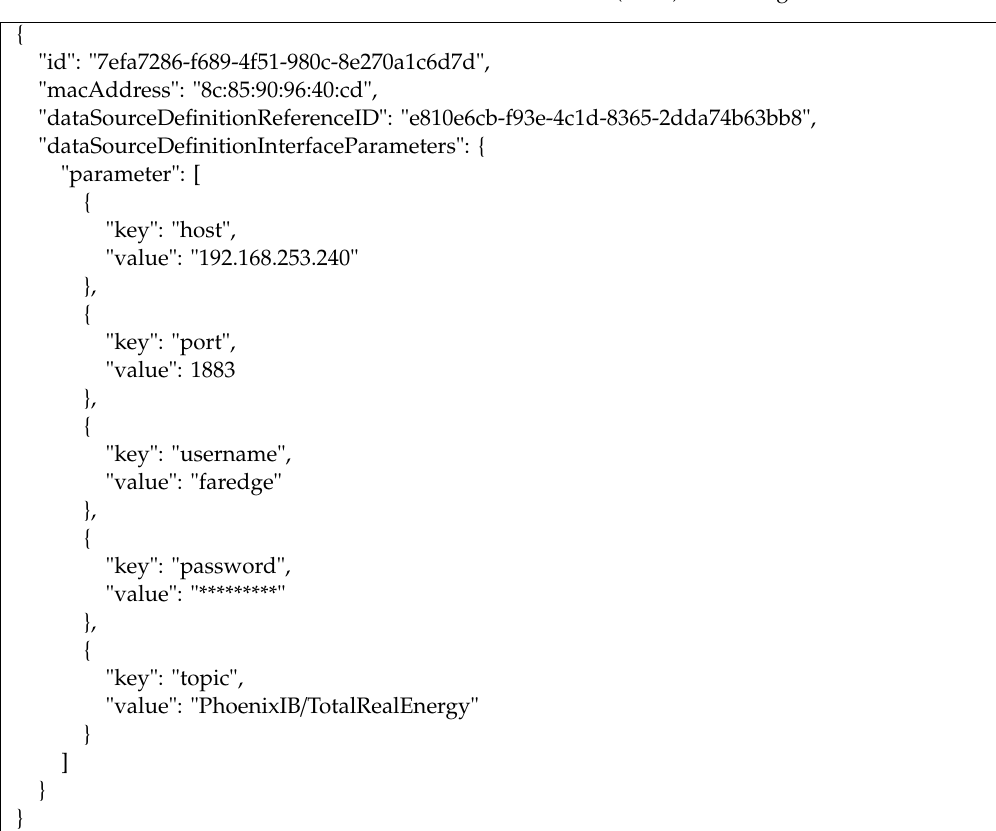
Table 4. Data Source Manifest (DSM) Modelling.